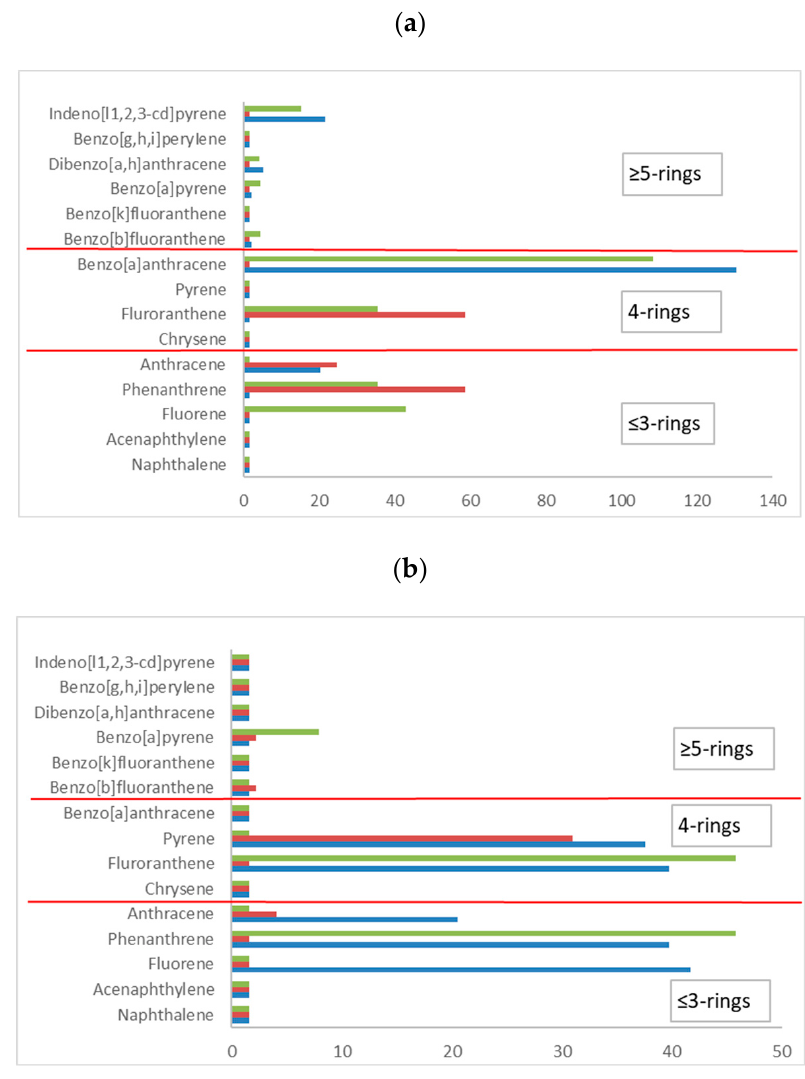
Figure 2. The PAH concentration dependent on the number of the benzene rings in: ( a ) TSP samples and ( b ) PM4 samples. The red lines are the borders between the PAH groups with different number of rings. Table 5. The PAH diagnostic ratios in TSP and PM4 samples collected in the garage of the fire station unit.